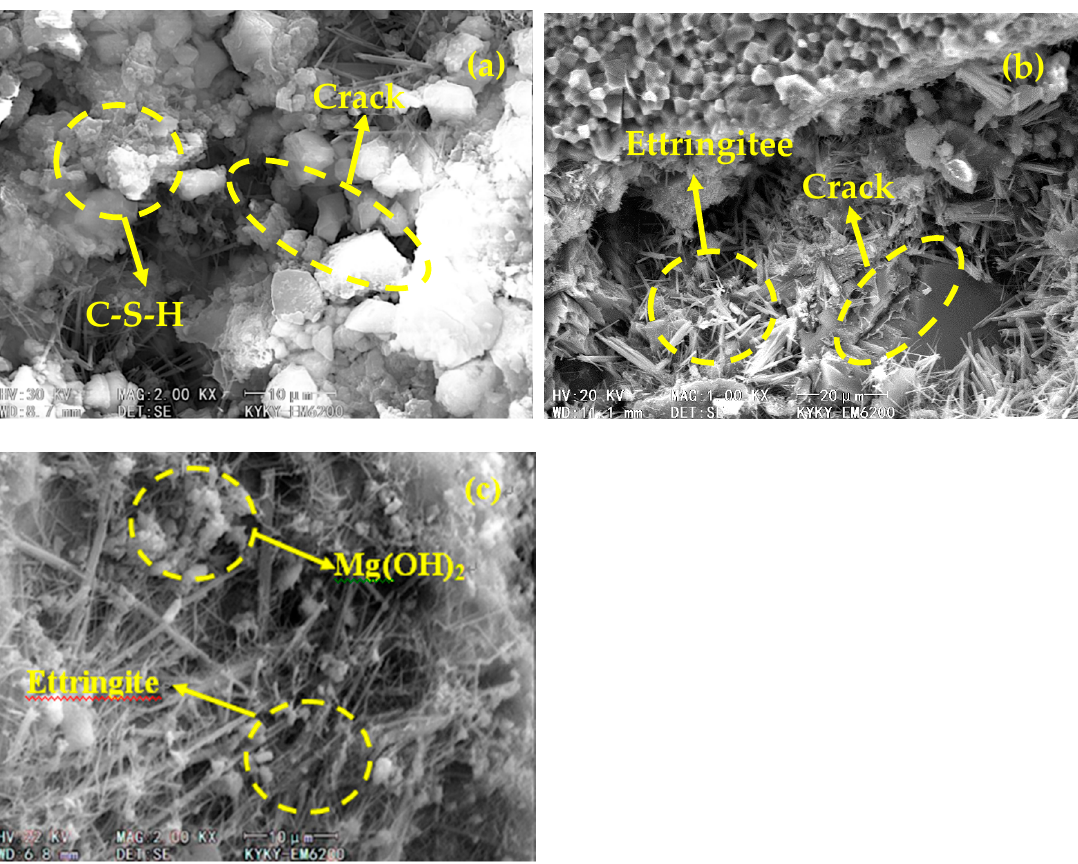
Figure 6. Microstructures of various concretes after 75 freezing and thawing cycles: ( a ) OC; ( b ) UM 10 ; and ( c ) UM 21.